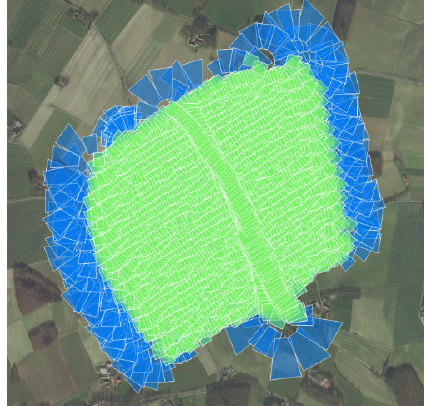
Figure 1: Flight pattern, green images are selected for photogrammetric processing